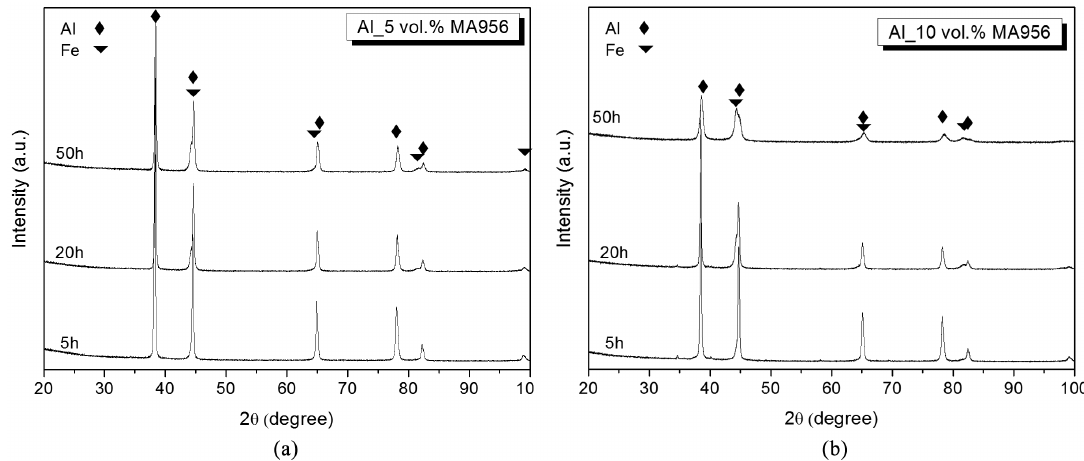
Figure 2. XRD patterns of mechanically alloyed powder as a function of milling time. (a) Al_5 vol.% MA956; (b) Al_10 vol.%